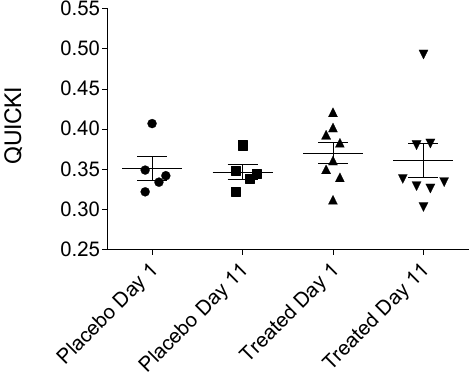
Figure 7. QUICKI (quantitative insulin sensitivity check index) of the placebo- and fenugreek-treated subjects.